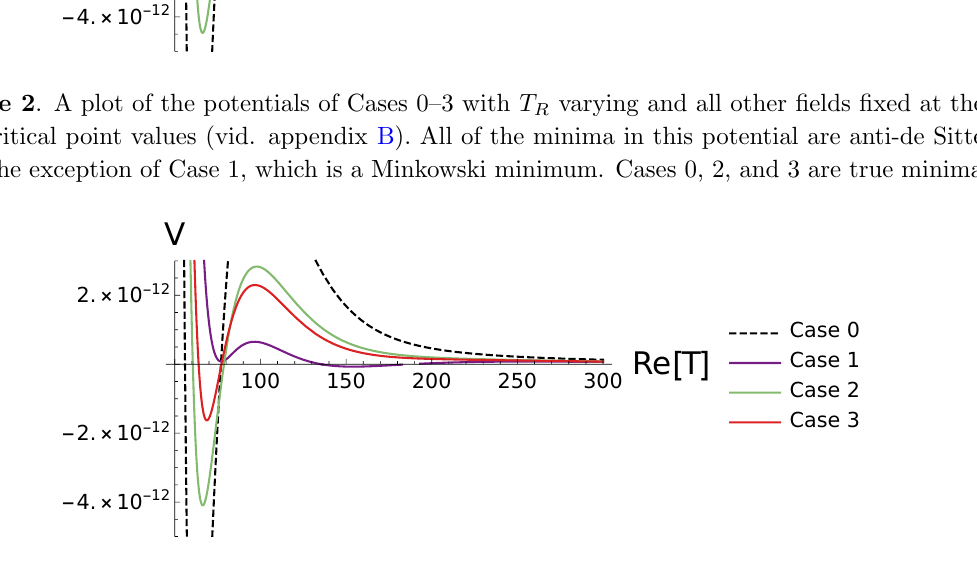
Figure 3 . A plot of the potentials of Cases 0{3 with T R varying and all other (cid:12)elds (cid:12)xed at their de Sitter critical point values (vid. appendix B). All of the apparent maxima shown here are in fact saddle points once we account for all (cid:12)elds.